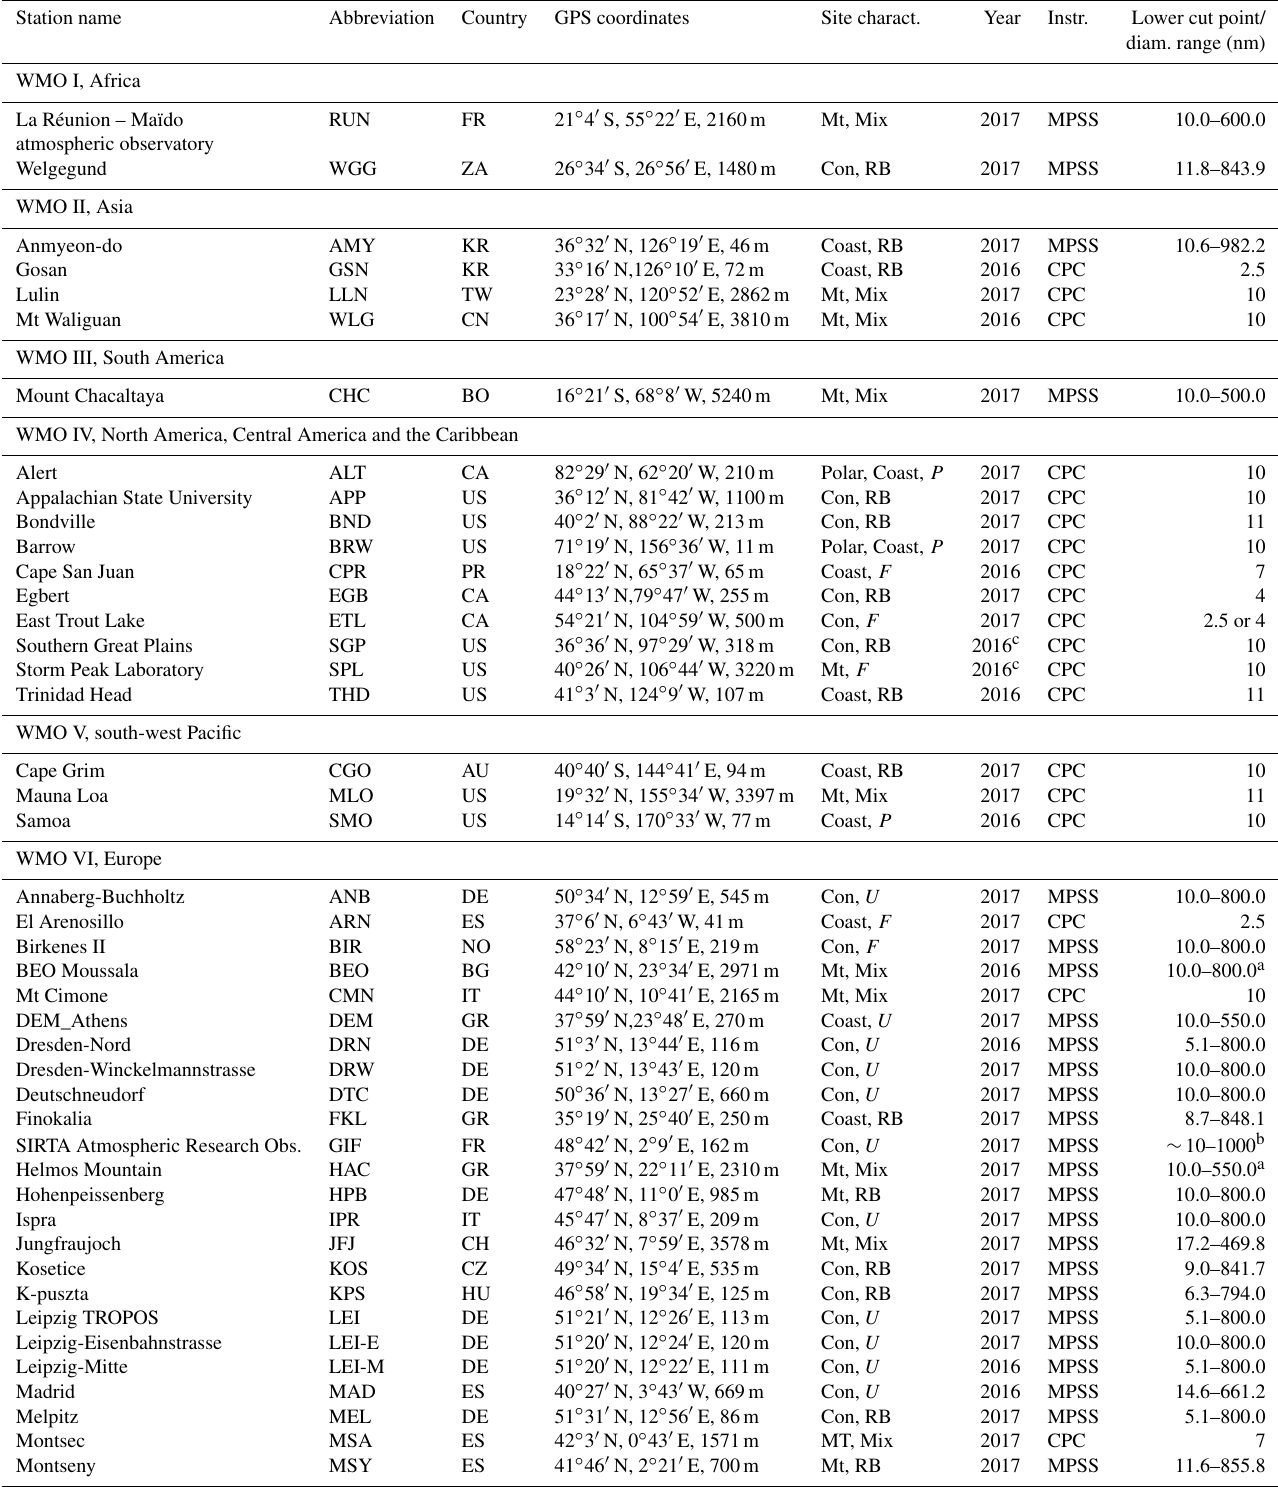
Table 1. List of SARGAN stations included in the present study. The geographical (with the following abbreviations: Mt for mountain, Con for continental and Coast for coastal) and footprint (RB for rural background, F for forest, U for urban, P for pristine and Mix for mixed) categories are indicated for each site, together with the year considered in the analysis (2016 or 2017), the type of instrument operated at the site (CPC or MPSS) and the corresponding cut point or diameter